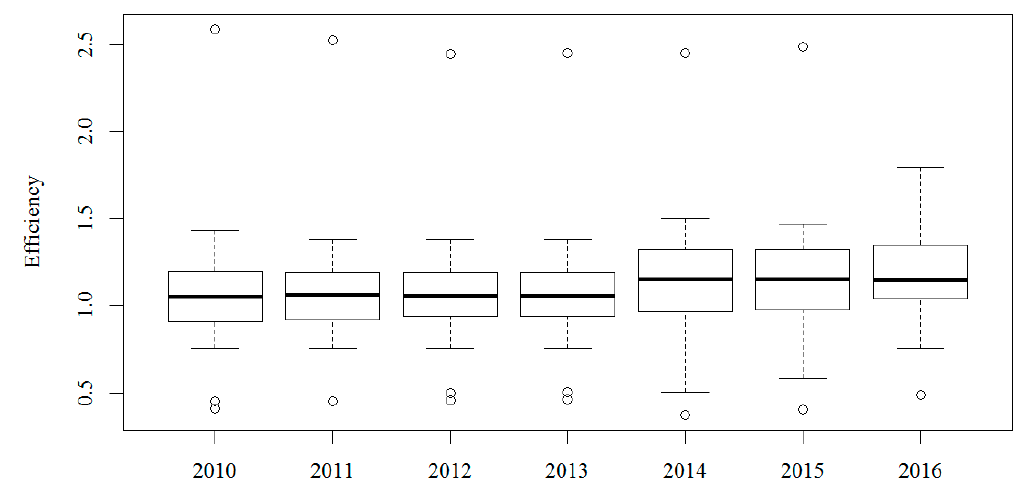
Figure 1. Pooled super-e ffi ciency scores boxplot.